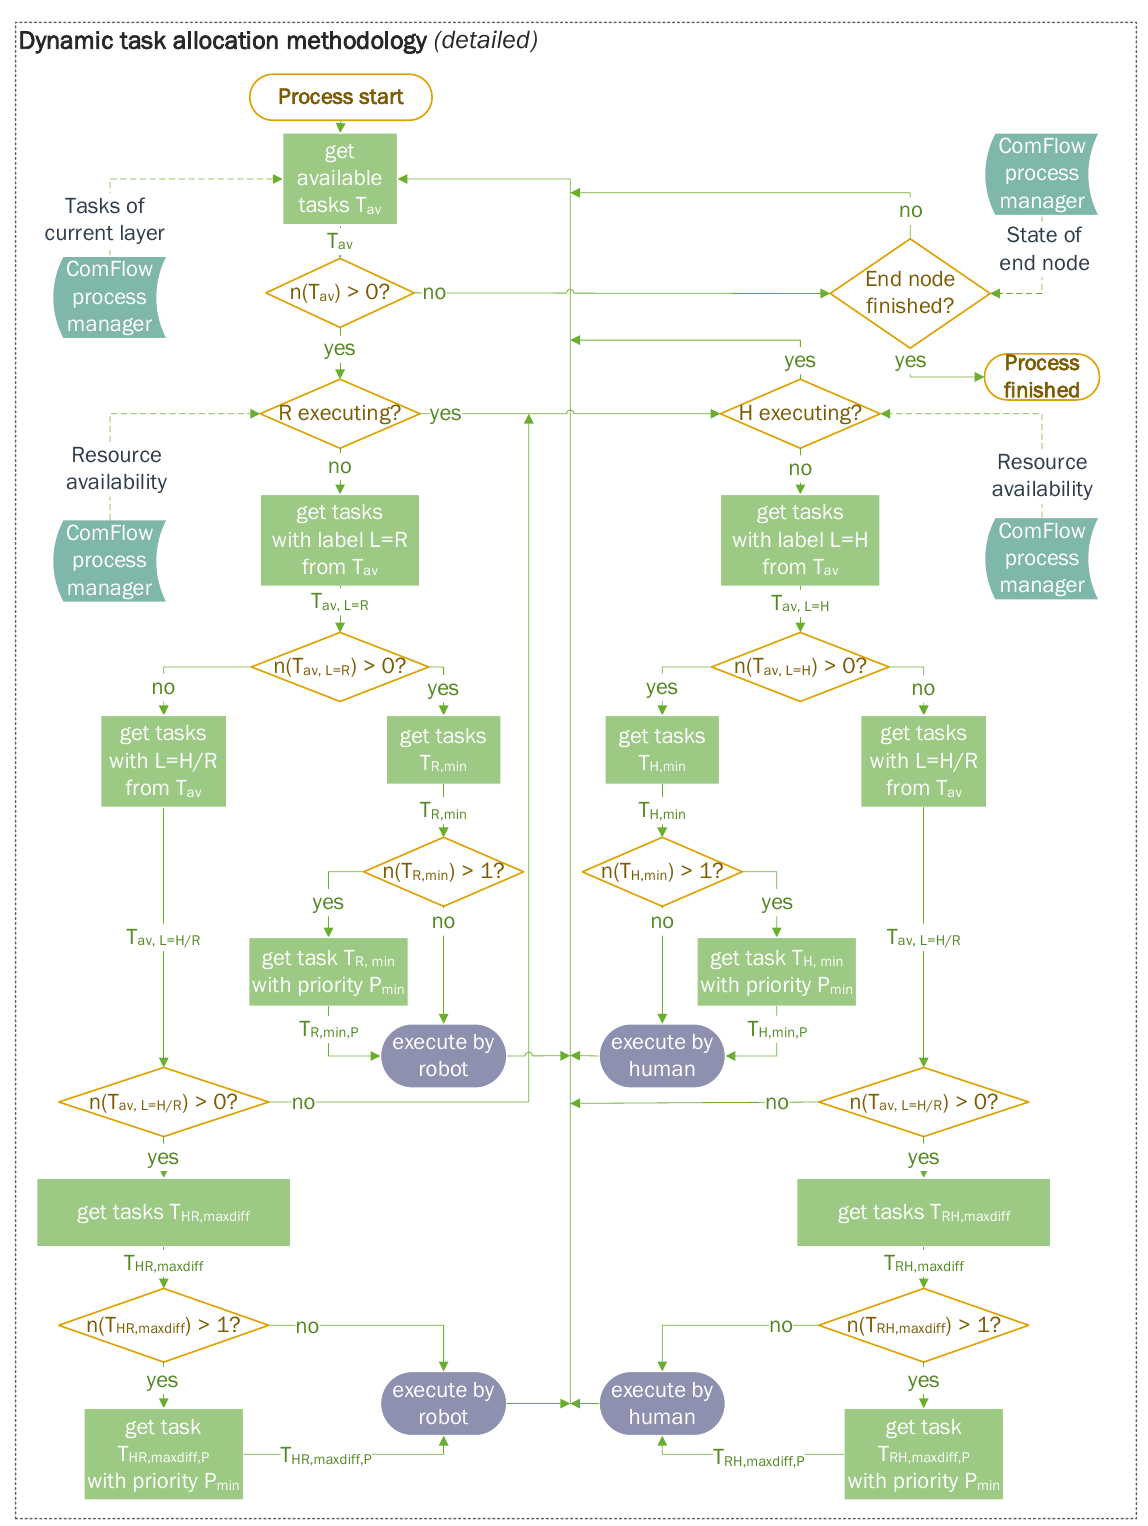
Figure A2. Detailed version of the flowchart of the proposed methodology for dynamic task allocation. The iteration is continuous, i.e., after an assignment, the decision logic is immediately repeated by requesting currently available tasks again without waiting for the completion of the last assigned task.